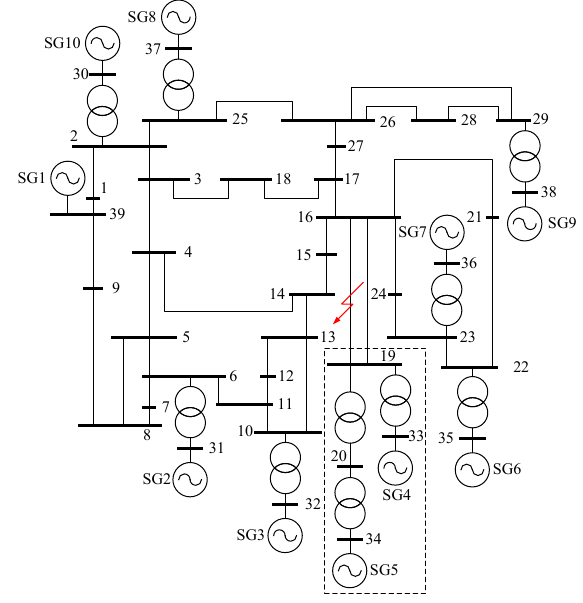
Figure 5. Diagram of the test system NE39bus.